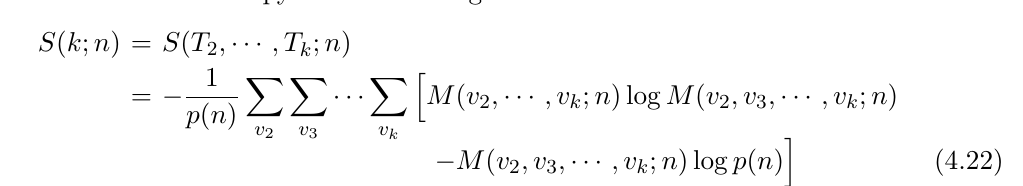
Figure 6 . Figures showing entropy S